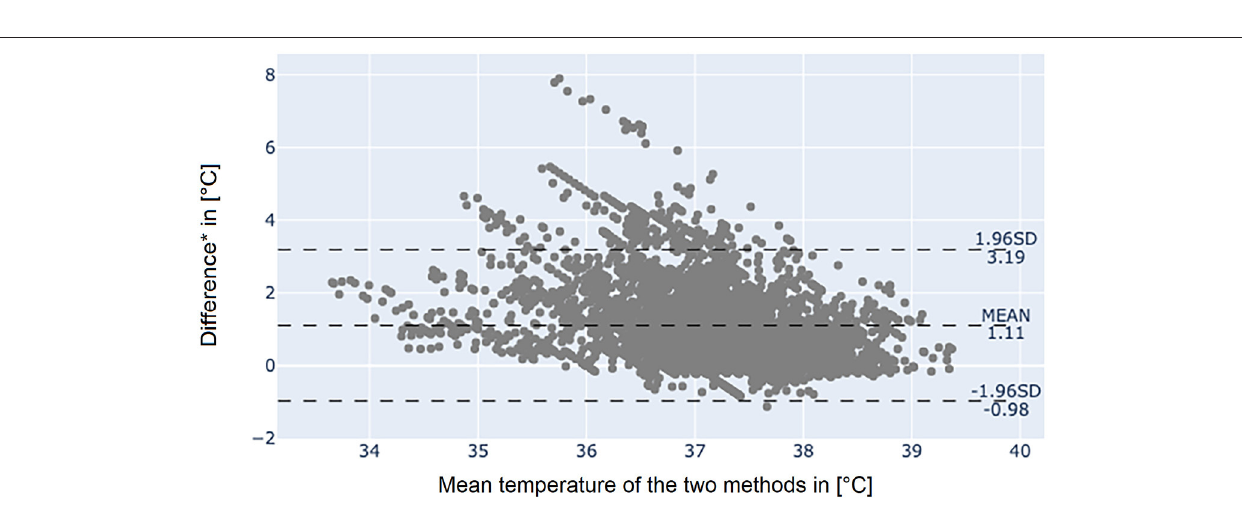
FIGURE 4 | Bland-Altman plot between bladder catheter and the adhesive axillary thermometer Steady Temp. *Bladder catheter values minus adhesive axillary thermometer values. SD, standard